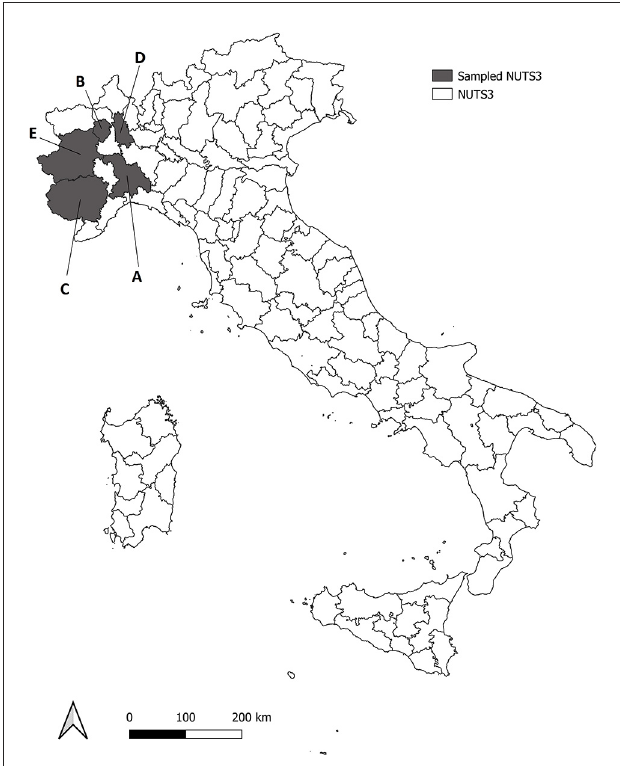
FIGURE1 Roe deer, wild boar and red fox analyzed were sampled from five Provinces (NUTS3) in North western Italy, in gray in the map (NUTS3–Nomenclature of Territorial Units for Statistics, level 3). Sampled NUTS3 are Alessandria (area A), Biella (area B), Cuneo (area C), Novara (area D) and Torino (area